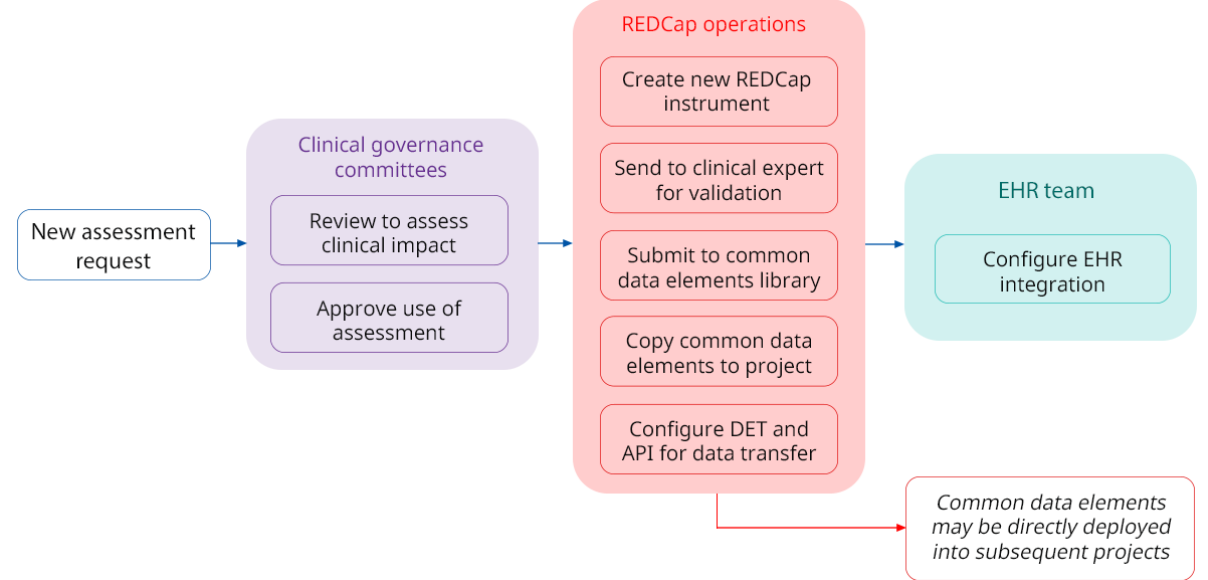
Figure 4. High-level workflow for clinical instrument development on the Clinical REDCap instance. The review is conducted by clinical committees to align assessments. API: application programming interface; DET: data entry trigger; EHR: electronic health record; REDCap: Research Electronic Data